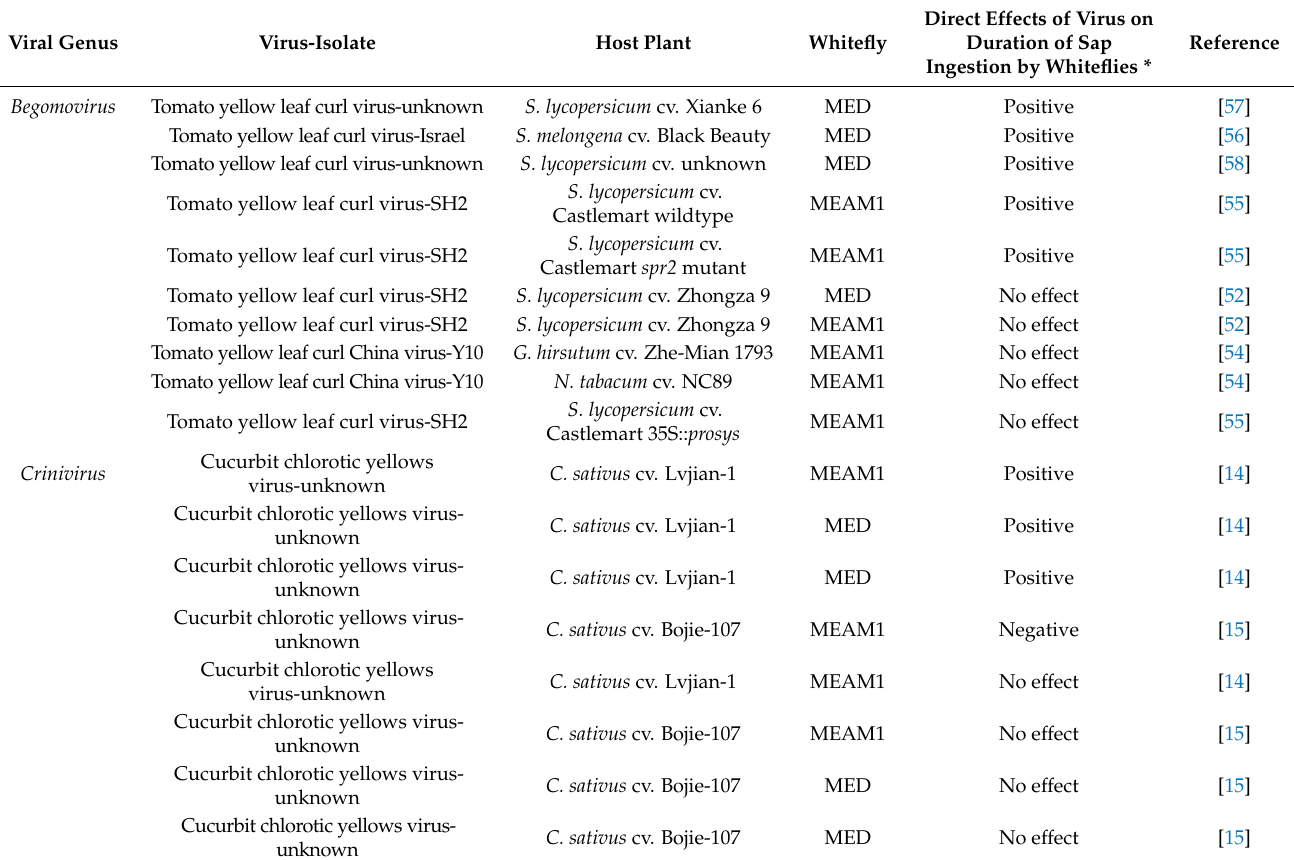
Table 4. Direct effects of virus infection on whitefly feeding